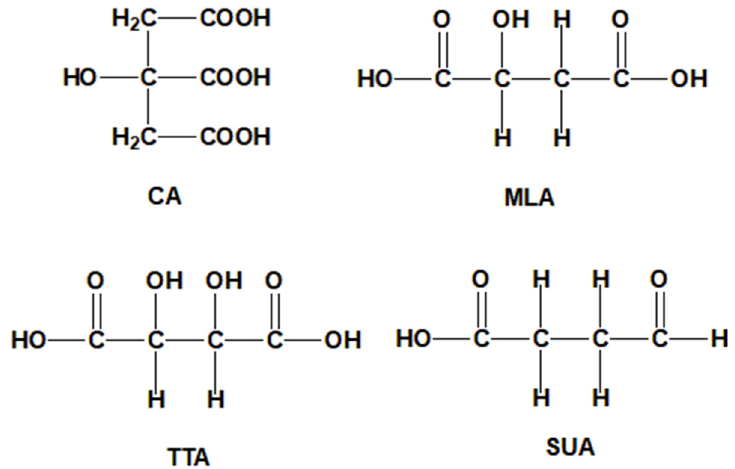
Figure 1. Structures of the polycarboxylic acids.